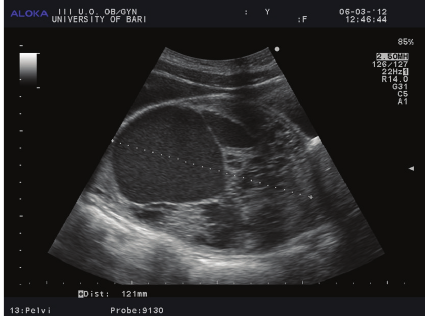
Figure 1: Transabdominal ultrasound showing a right parauterine mass with a complex echogenicity, 12cm in diameter, deviating the uterus to the left side.